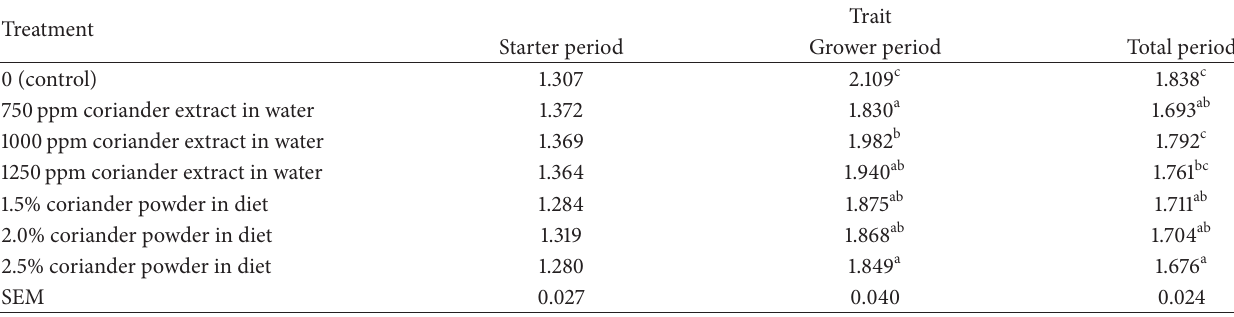
Table 6: Feed conversion ratio mean ( ± SEM) of Ross 308 broilers at starter (1–21 days), grower (22–42 days), and total periods (1–42 days) fed diets or water containing the different levels of coriander ( Coriandrum sativum L.) powder and